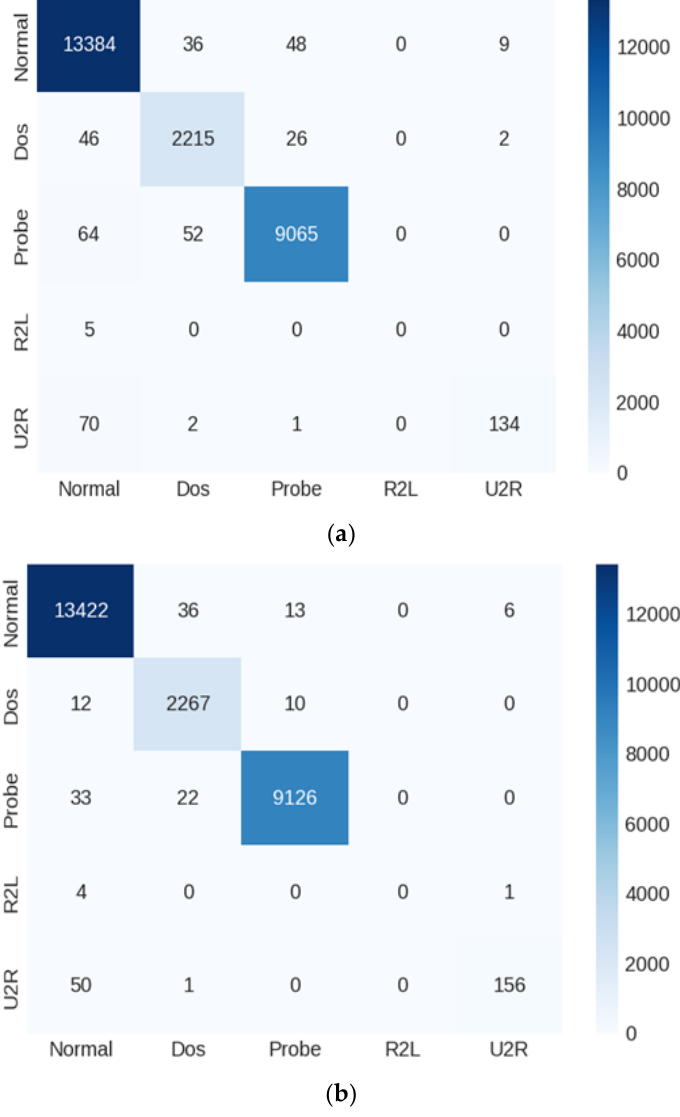
Figure 4. ( a ) Custom CNN model confusion matrix. ( b ) CNN model with LSTM confusion matrix. Table 6. Validation metrics of the CNN-LSTM model. Precision Recall f1-Score